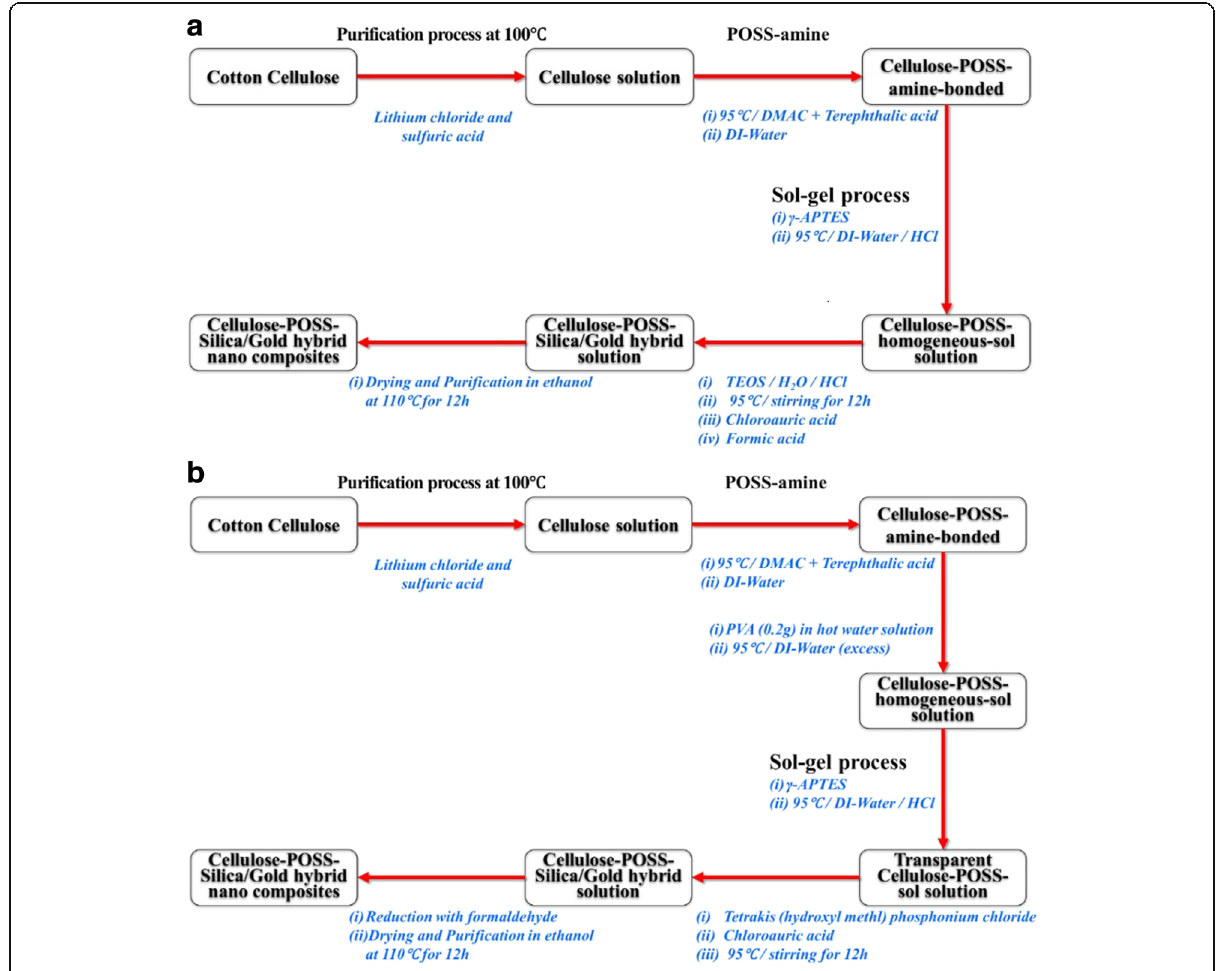
Fig. 1 Synthesis of cellulose-amino POSS hybrid composite by (a) sol-gel process (b) PVA/THPC